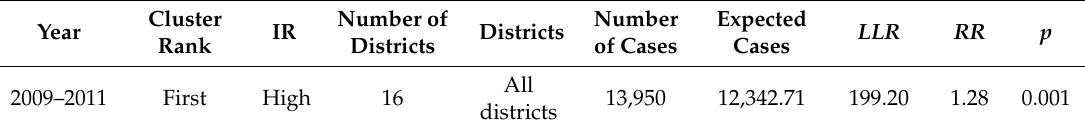
Table 2. Purely temporal scan statistics analysis of high and low IRs from 2009 to 2014.